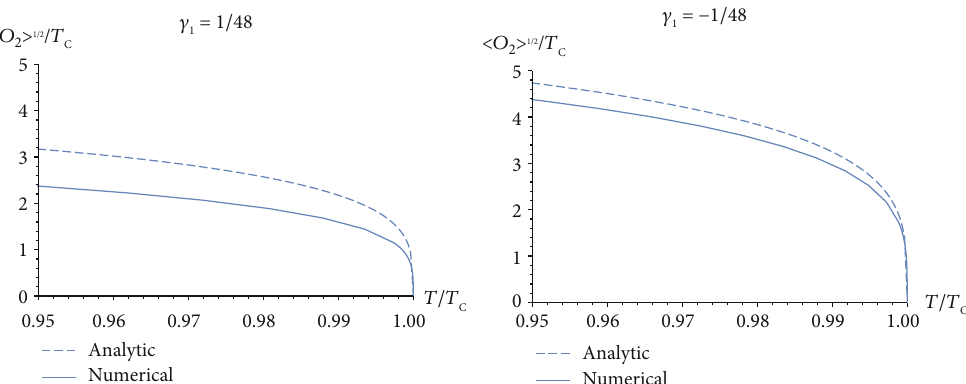
Figure 2: The condensation from 6-derivative theory for di ff erent γ